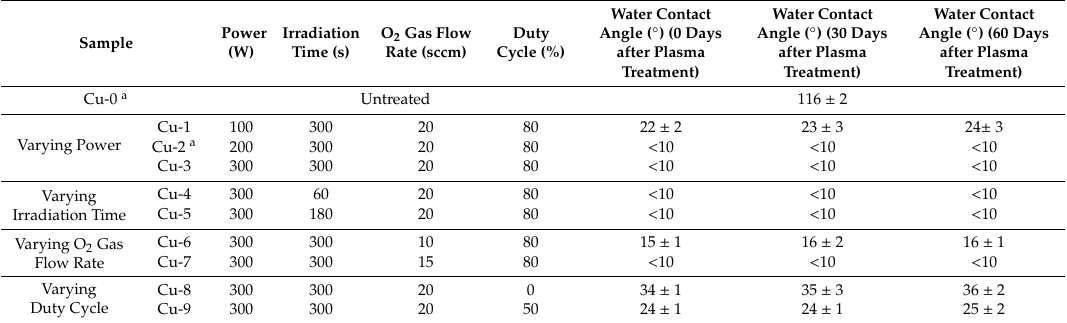
Figure 1. Schematic diagram of the P300 plasma device. Table 1. Summary of the plasma surface modification parameters and the corresponding water contact angle measurements.